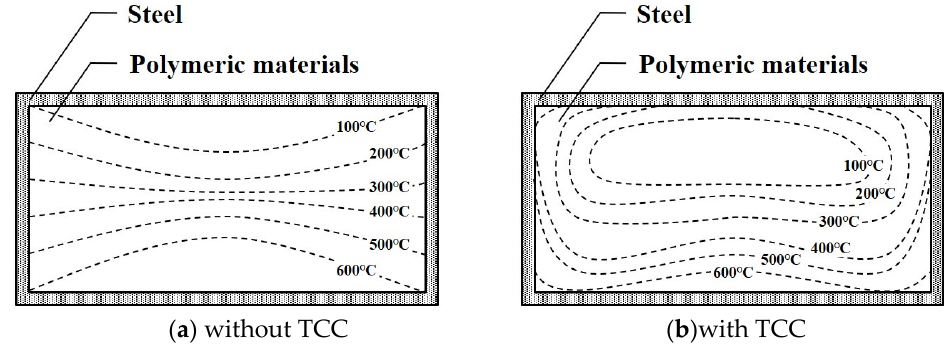
Figure 4. Examples of temperature distributions in hybrid floors: ( a ) without TCC ( b ) with TCC